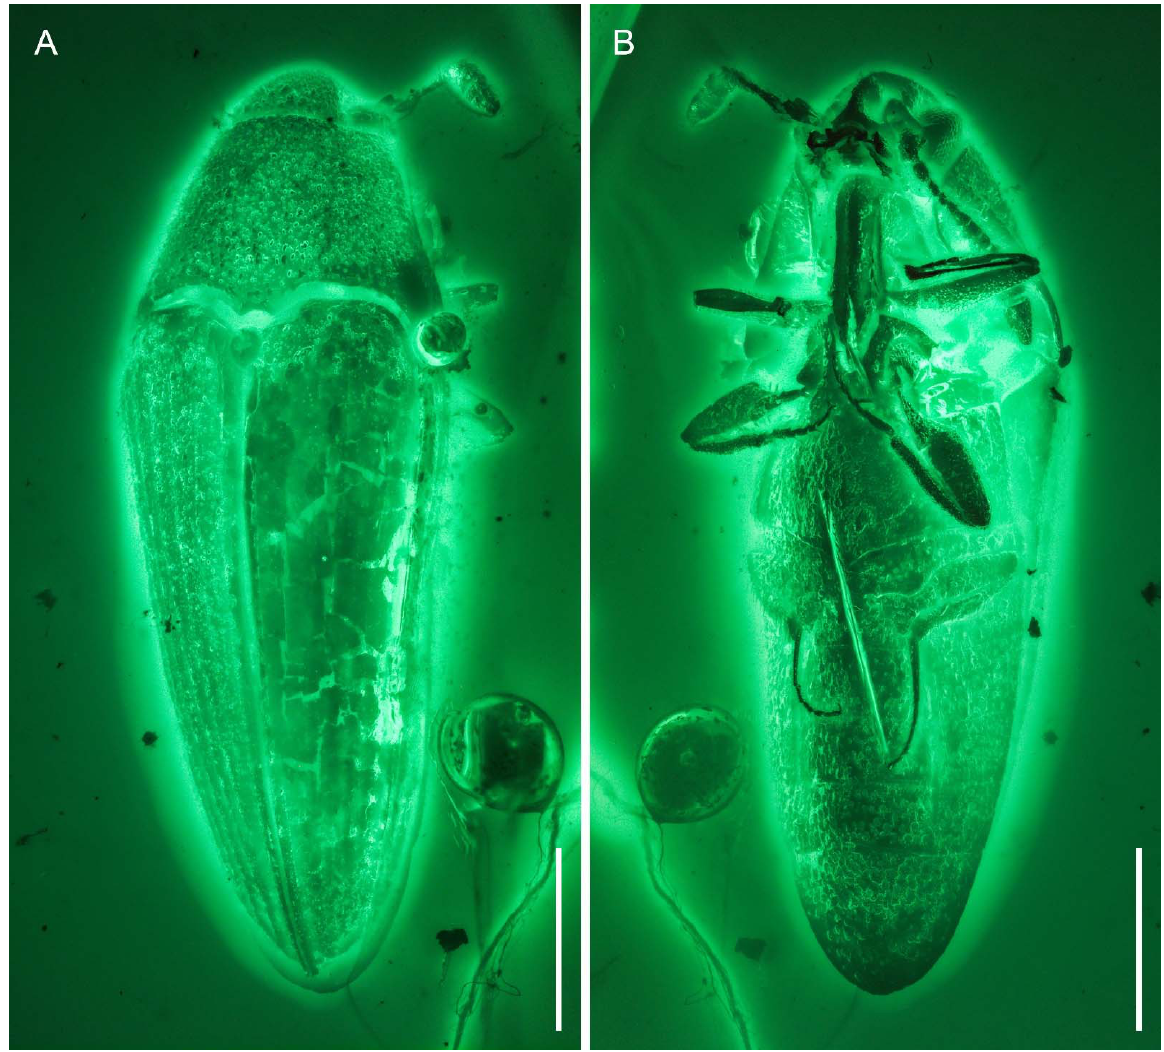
Figure 2. General habitus of Captopus depressiceps gen. et sp. nov. , holotype, NIGP173915, under widefield fluorescence. ( A ) Dorsal view. ( B ) Ventral view. Scale bars: 500 μ m.